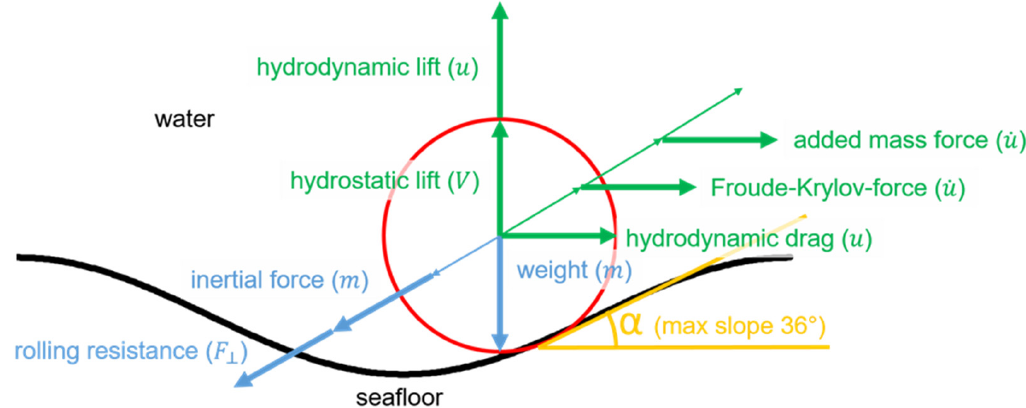
Figure 4. Loads on a cylindrical object in a symmetrical scour cavity in the presence of waves [10]].